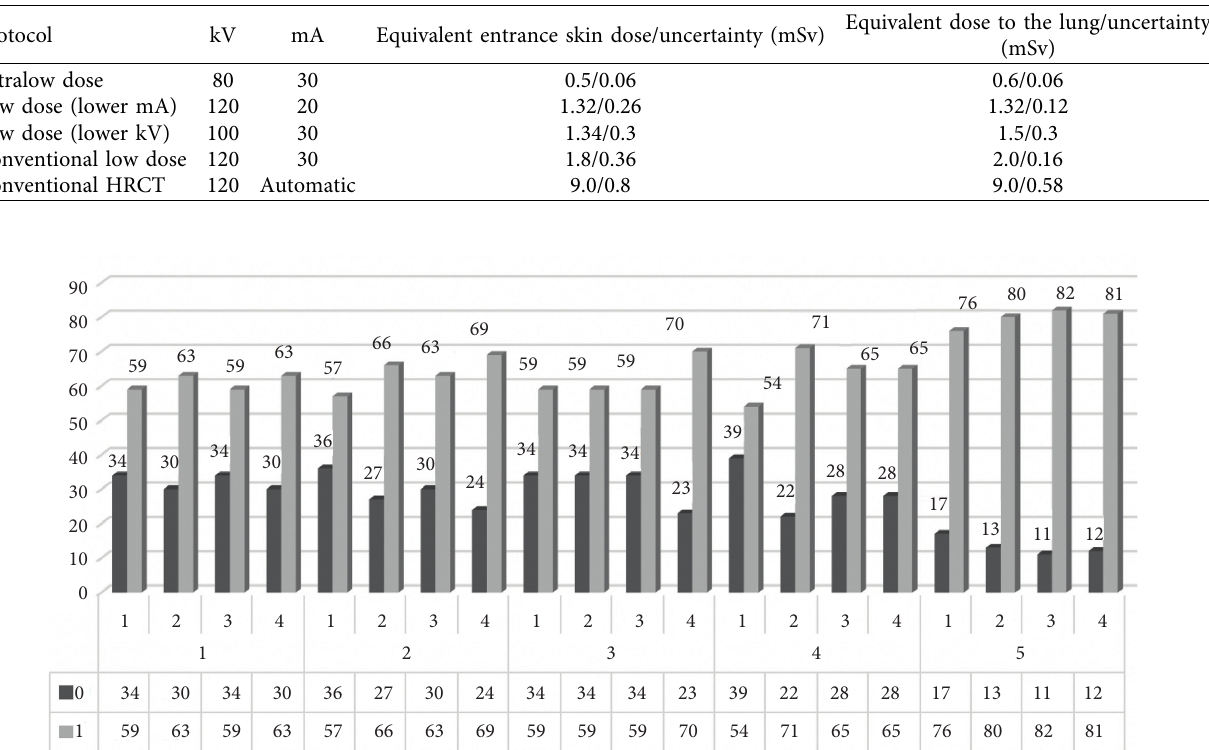
Table 2: Estimated equivalent